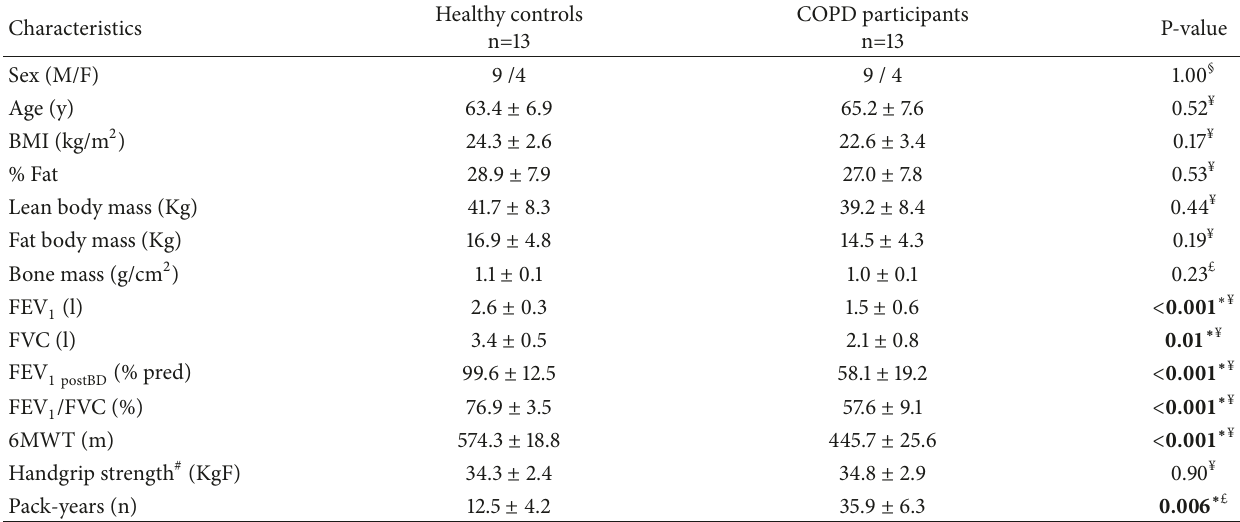
Table 1: Characteristics of participants